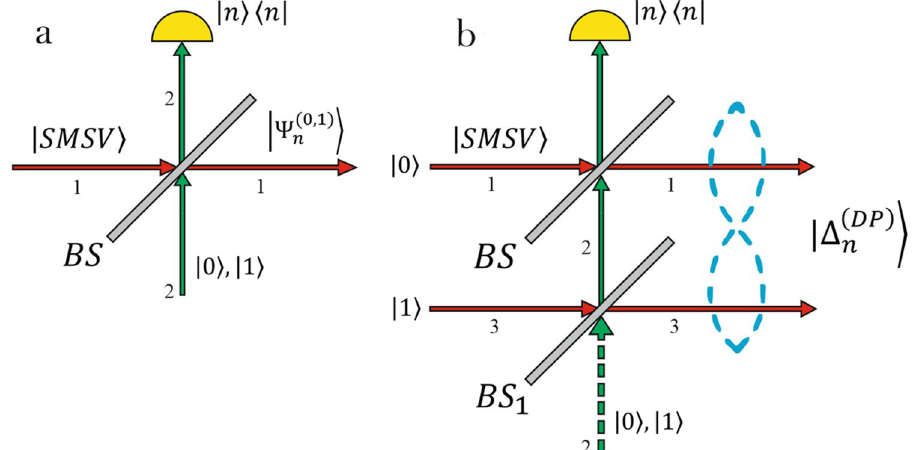
Figure 1. ( a,b ) Optical schemes adjusted for measurement-induced generation of CV states of definite parity (left subfigure) and deterministic implementation of CV-DV entanglement (right subfigure) by superimposing input SMSV state with either vacuum, single photon or delocalized photon created by lower BS in the picture on the